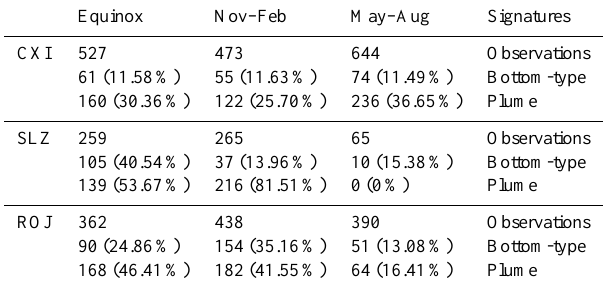
Table 3. Spread F occurrence over Christmas Island, São Luís and Jicamarca stations, separated by radar